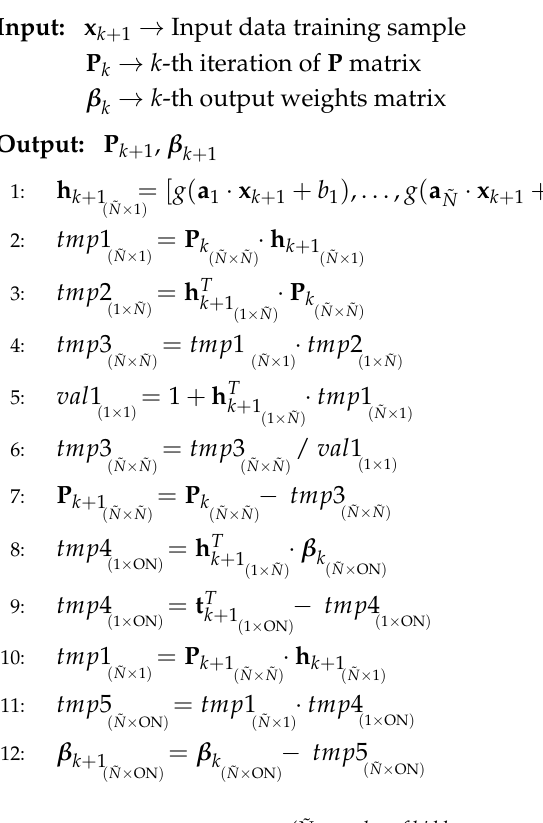
Algorithm 1 Pseudocode of a OS-ELM